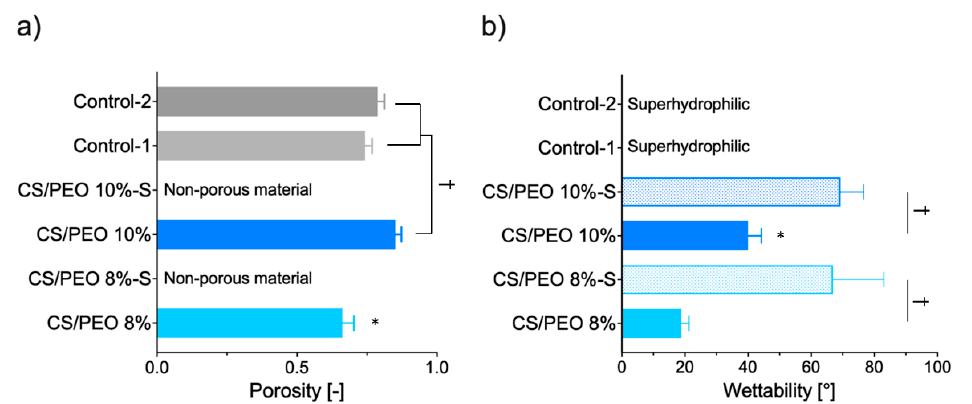
Figure 3. ( a ) Porosity and ( b ) wettability (water contact angle) of CS/PEO nanofibers as compared to poly(dimethylsiloxane) modified nanofibers CS/PEO-S and commercial hydrofiber-like wound dressings (Control-1; Control-2) (presented as the mean value ± standard deviation, n = 3). * represents significant differences with p ≤ 0.05 between uncoated formulations; † symbolizes differences with p ≤ 0.05 between uncoated nanofibers and ( a ) Controls or ( b ) S-coated formulations. In the healing process, it is important to remove excessive exudate fluid from the wound bed in order to facilitate and to speed up the reepithelization process [33].